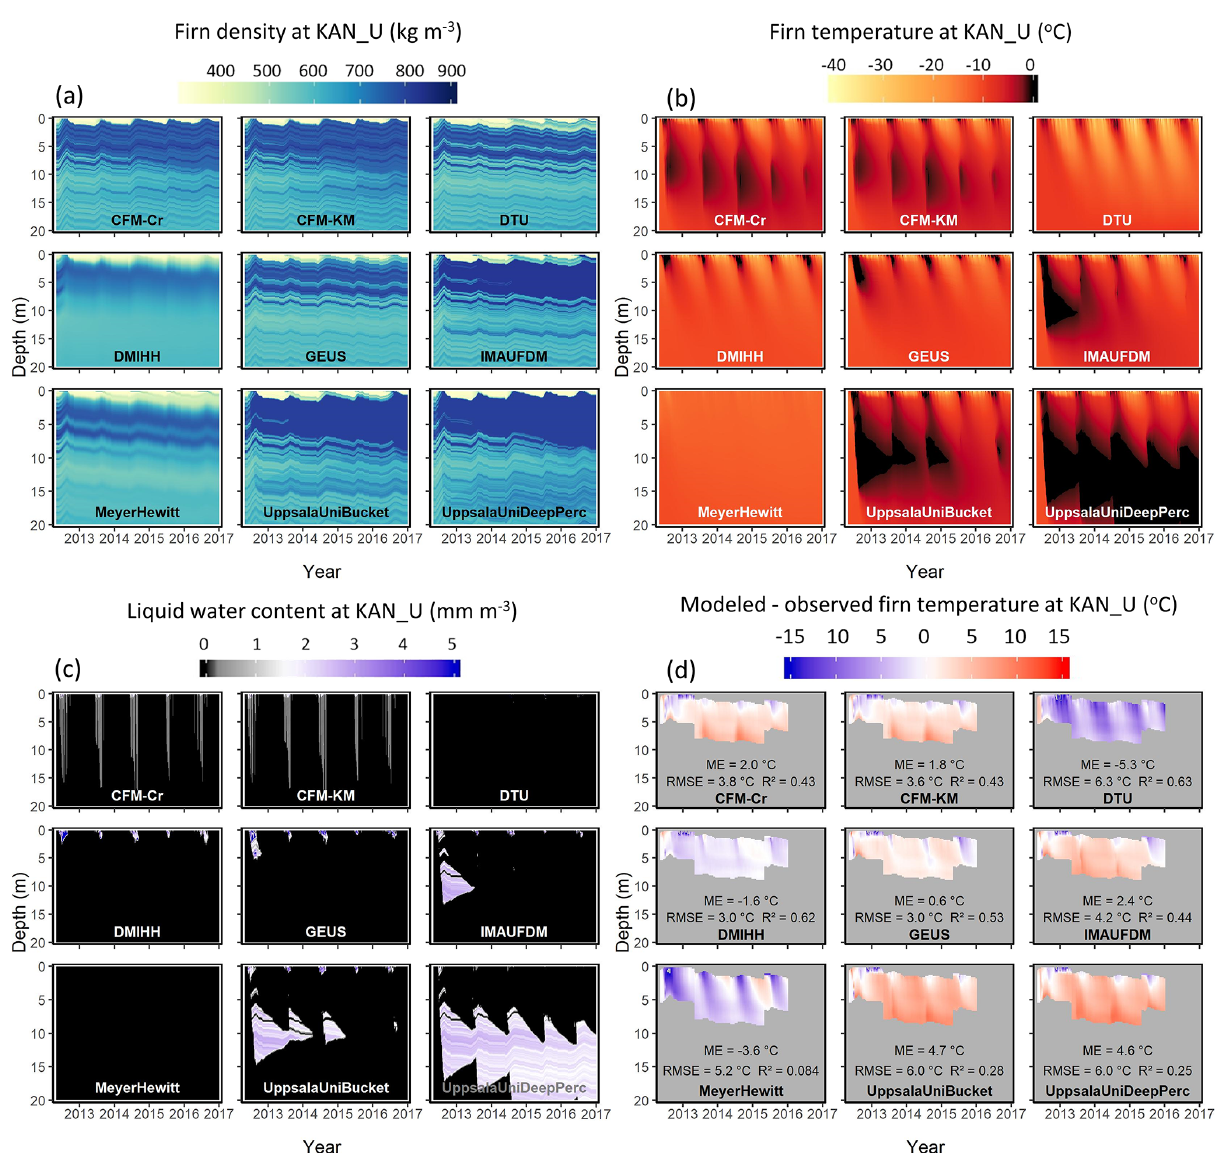
Figure 8. Simulated firn density (a) , temperature (b) , water content (c) , and deviation between simulated and observed firn temperature (d) at